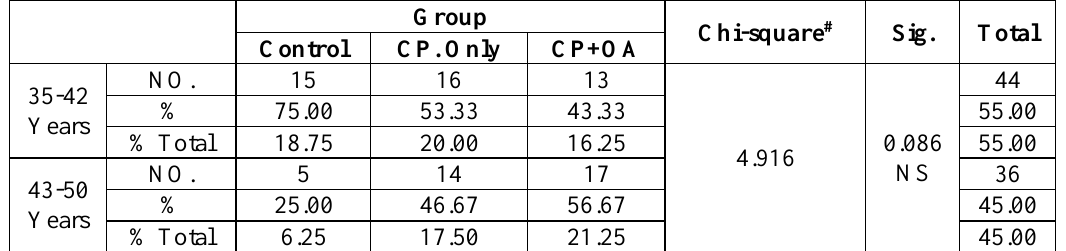
Table 2: Age distribution among study groups.